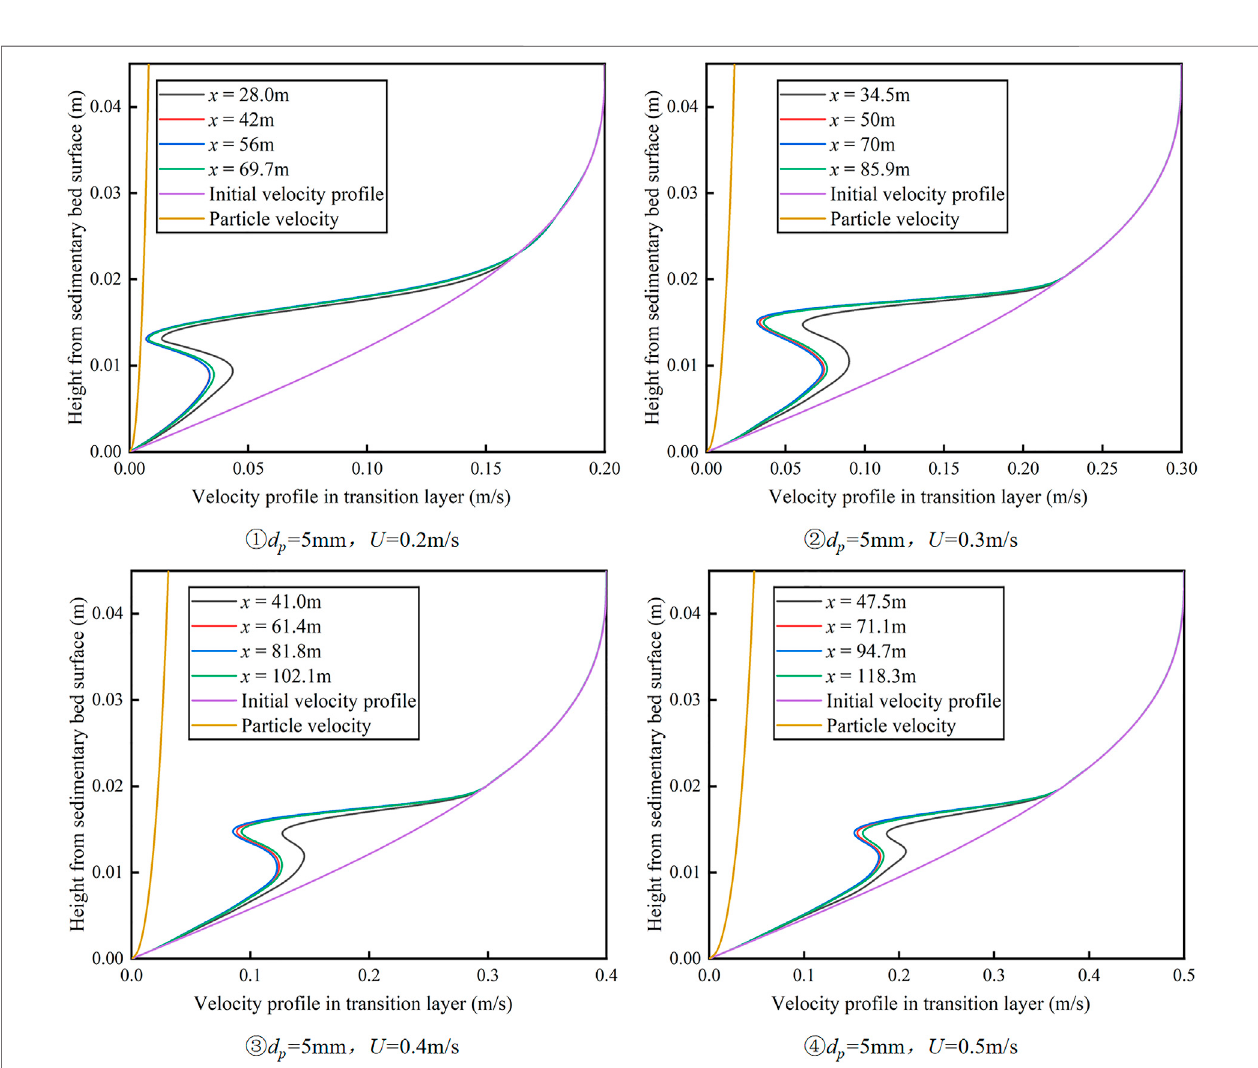
FIGURE 11 | Variation of velocity distribution in the transition layer with fl ow velocity.